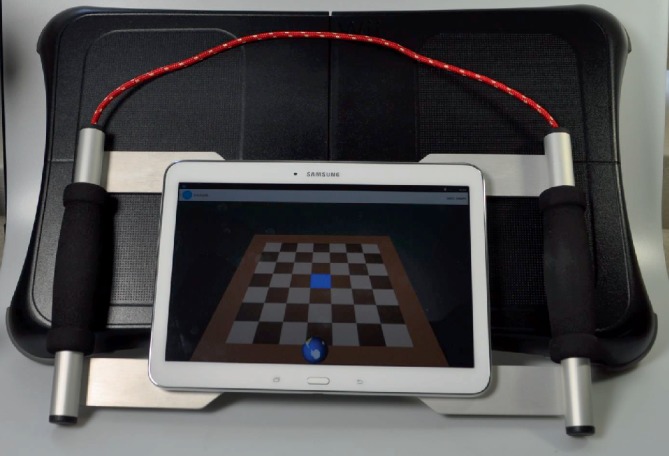
Homebalance system®.